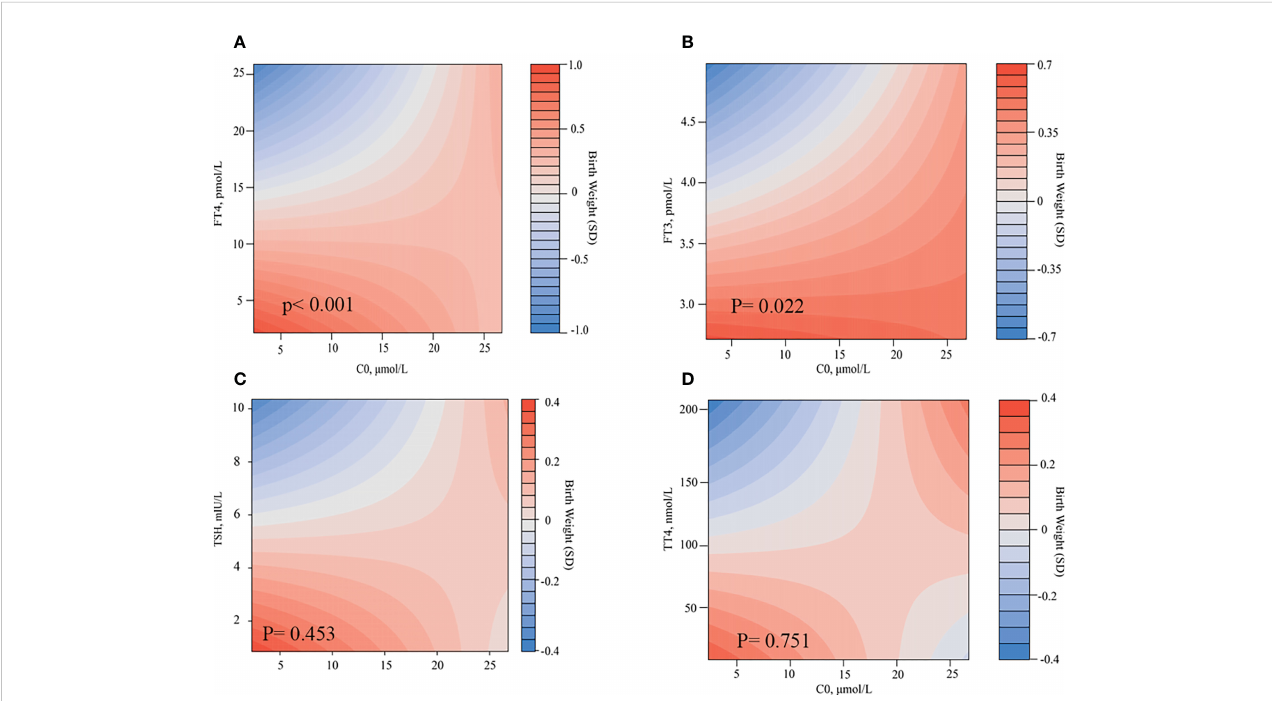
FIGURE 4 Combined effects of C0 and thyroid hormones in the second trimester on birth weight. Heatmap ( fi lled contour plot) for the correlation of birth weight (red indicates increased gestational age – adjusted birth weight, and blue indicates decreased gestational age – adjusted birth weight) according to the interaction of C0 and FT4 (A) , FT3 (B) , TSH (C) , and TT4 (D) in the second trimester. Analyses were adjusted for maternal age, BMI, parity, and fetal sex.